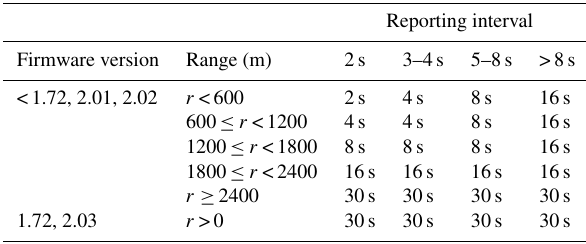
Table 1. Internal averaging interval applied in different CL31 firmware versions as a function of range r and reporting